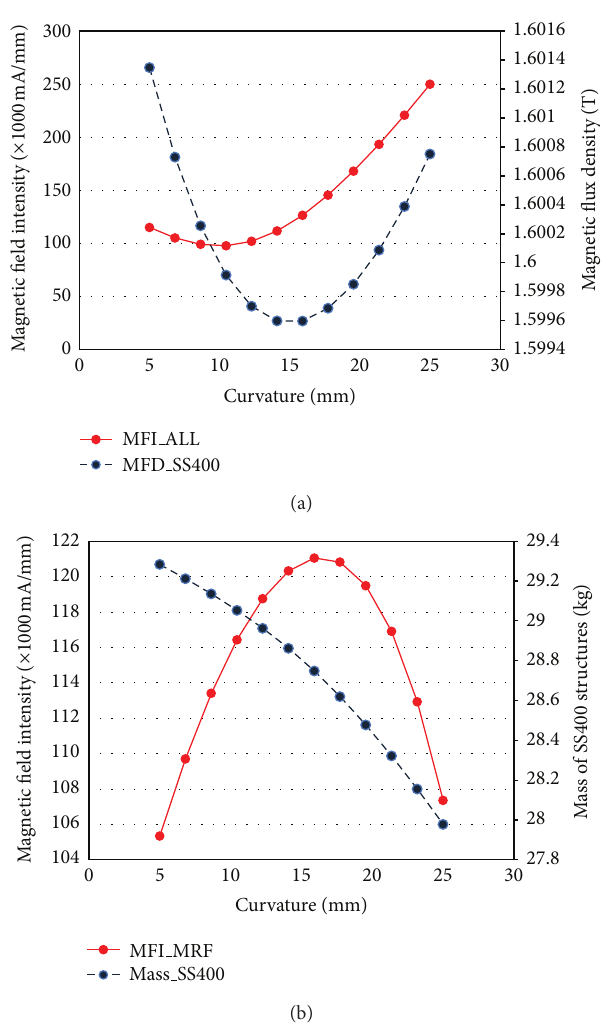
Figure 9: FEA results of the rotary MR damper with the curvature, R = 5 ∼ 25mm. (a) Maximum magnetic field intensity (MFI) of all components and magnetic flux density (MFD) of the SS400 cover case structure. (b) Average magnetic field intensity (MFI) of the MR fluid (MRF) and mass of the SS400 cover case structure.